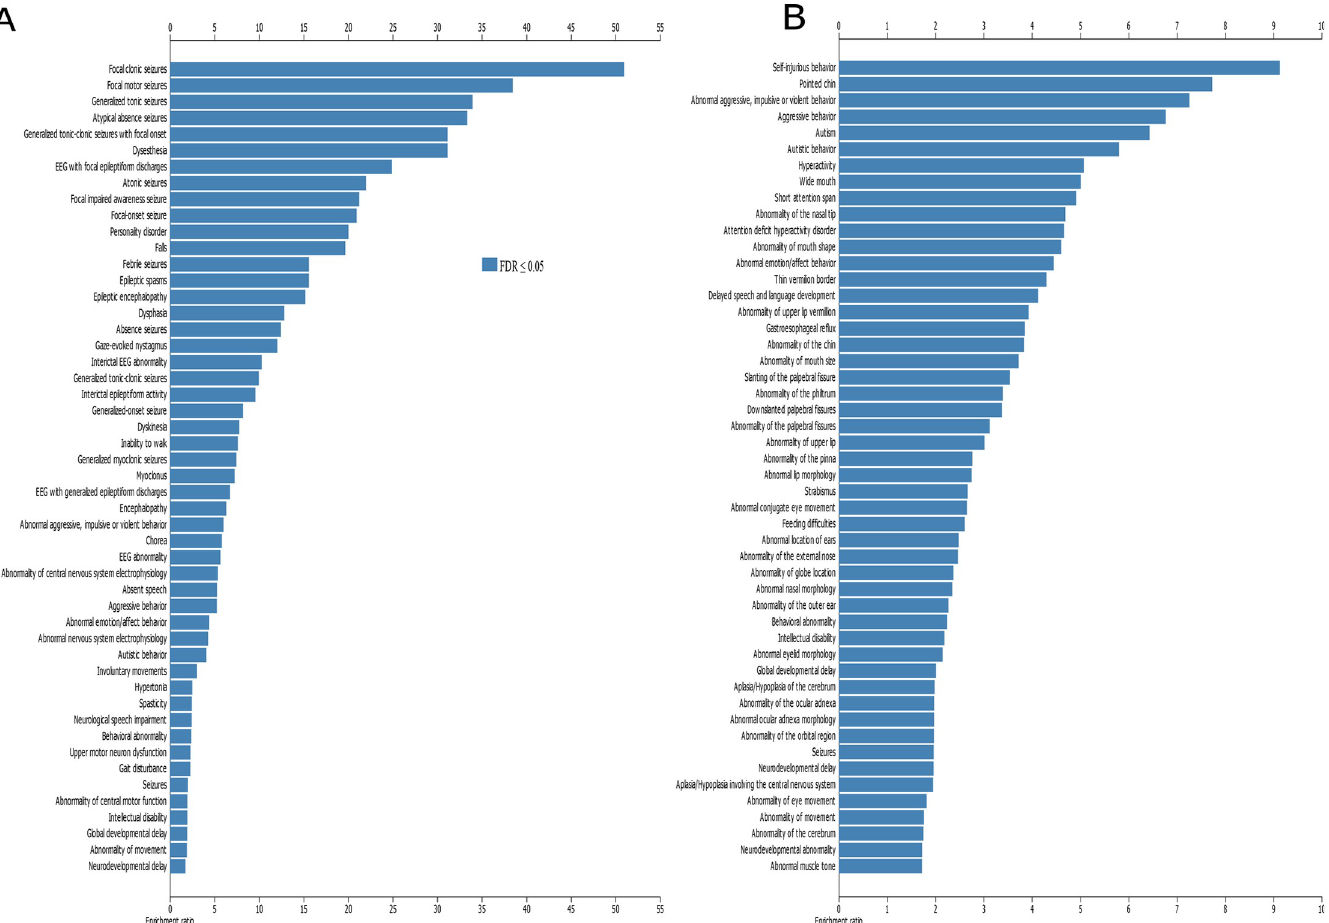
Fig 7. Co-Morbid phenotypes associated with ASD. (A) Top 50 terms enriched in CNS geneset, (B) top 50 terms enriched in CNS+PT geneset. X-axis denotes ratio of enrichment. Dark blue are terms below FDR < 0.05.